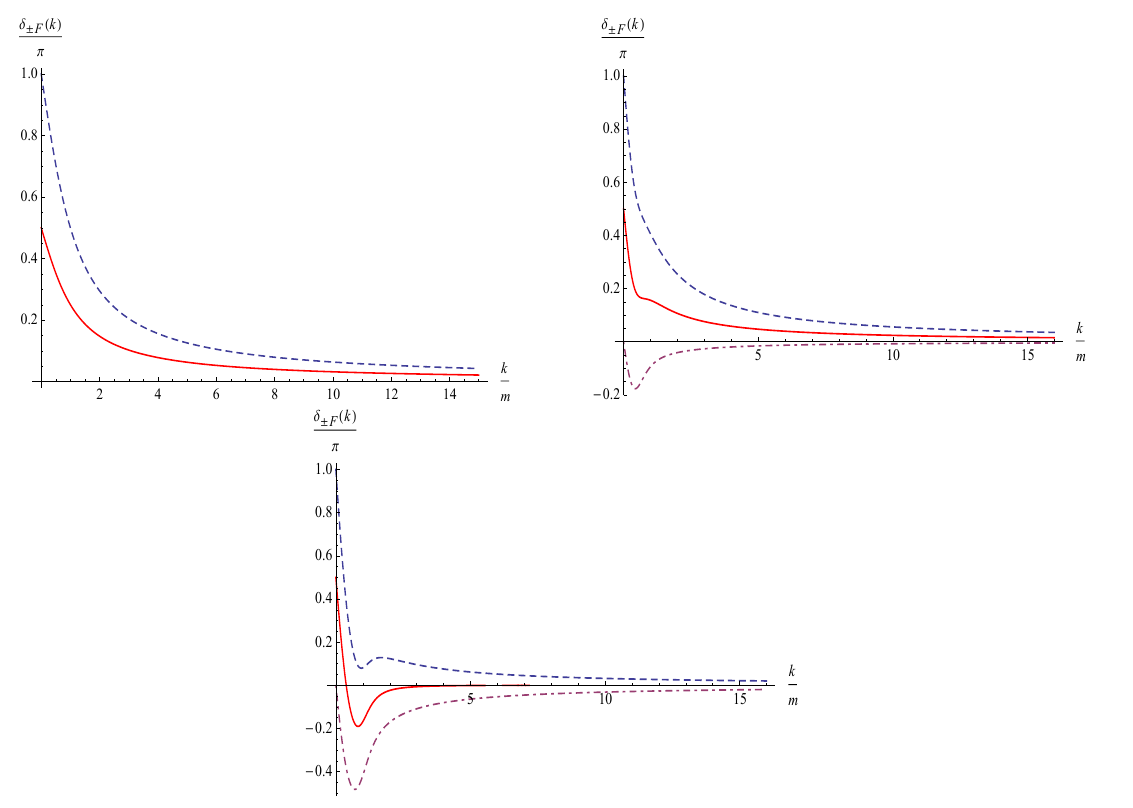
Figure 6 . Plots of the phase shifts (cid:14) (cid:6) ( k ) =(cid:25) , and (cid:14) F ( k ) =(cid:25) as functions of k=m , for (a) B = 0, (b) B = 0 : 5, and (c) B = 1 : 0 . The dashed, solid, and dotdashed lines correspond to (cid:14) + ( k ) =(cid:25) , (cid:14) F ( k ) =(cid:25) , and (cid:14) (cid:0) ( k ) =(cid:25) ,